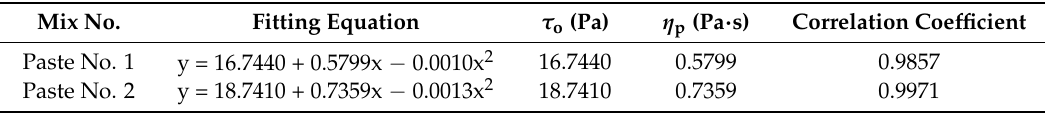
Table 6. Rheological parameters of cement pastes.